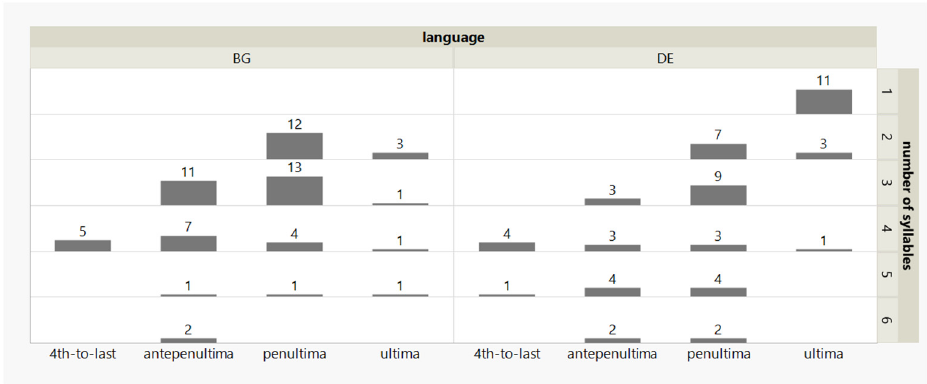
Figure 6. Stress position in the prosodic word in Bulgarian (left) and German (right).